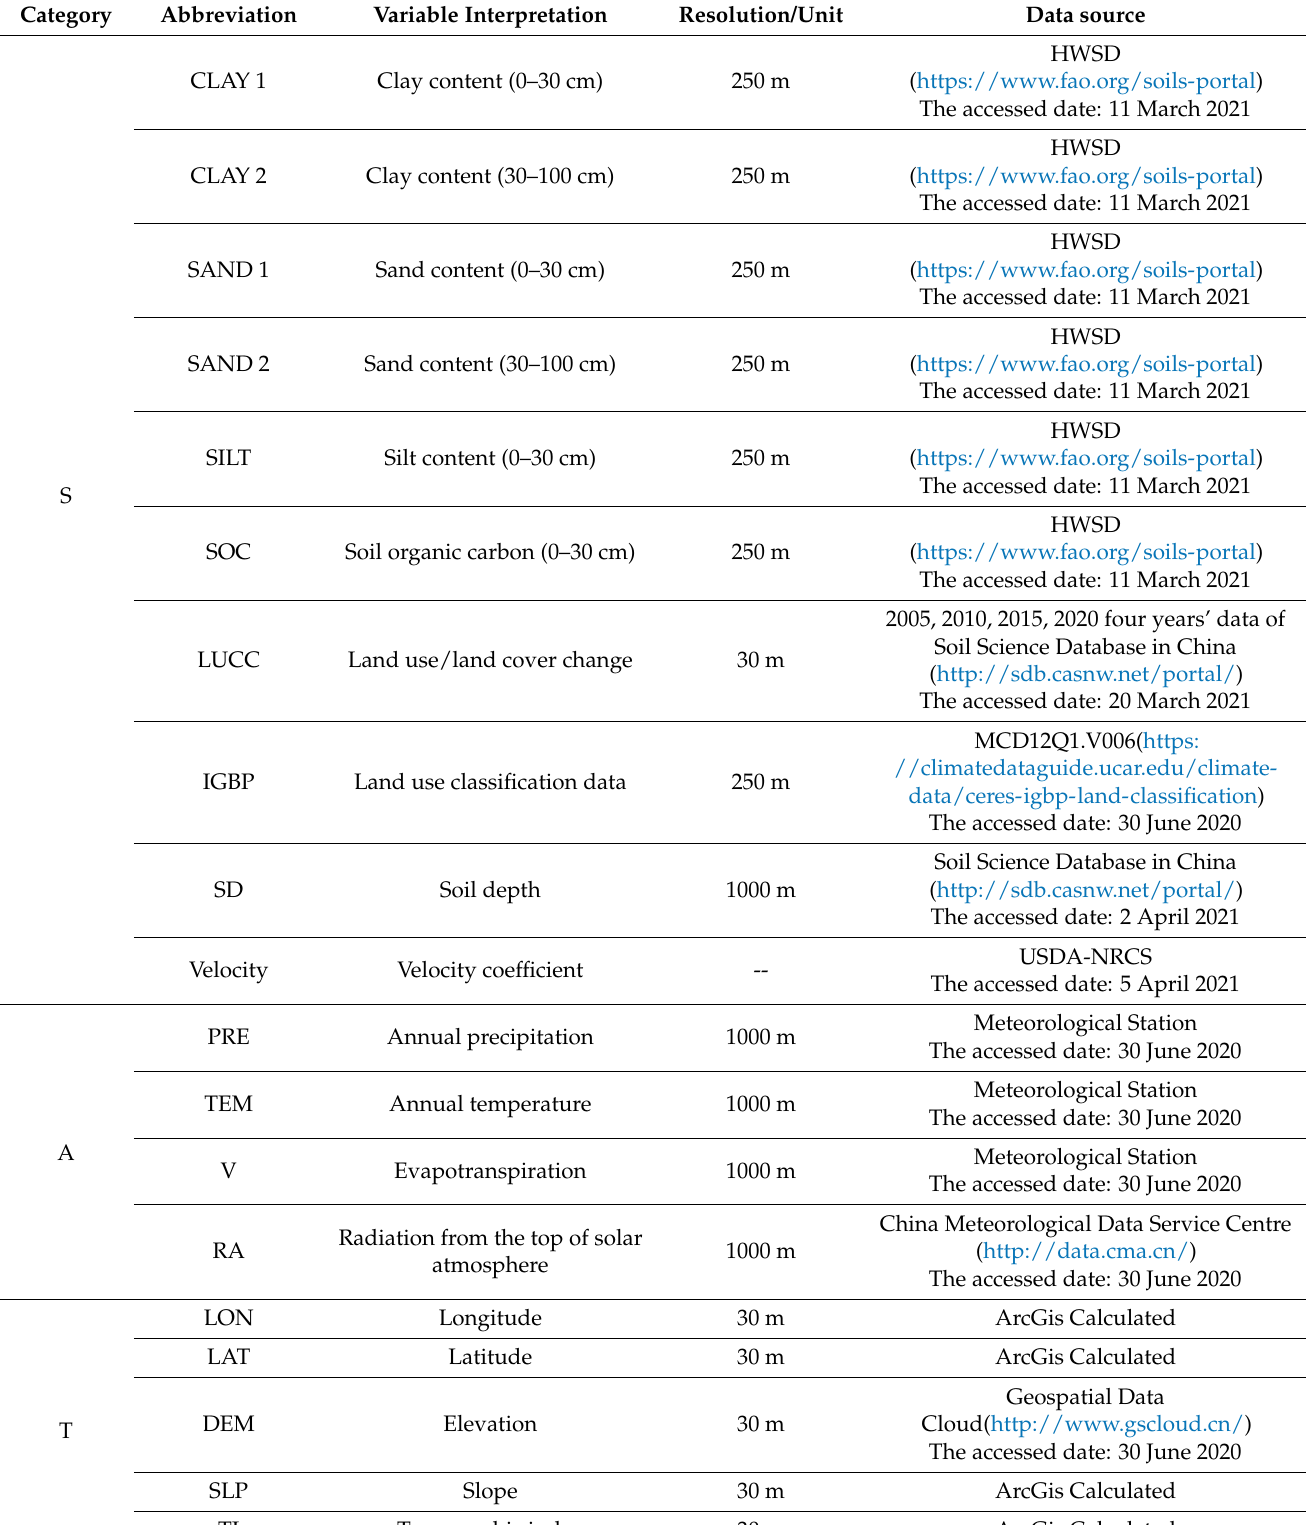
Table 1. The environment variables and data